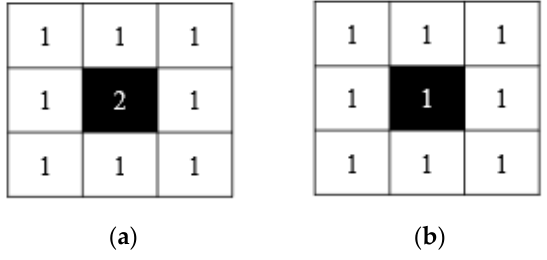
Figure 6. Gaussian Blur. ( a ) Raw image ( b ) after blurring. The first image is the raw image with a pixel value of 2 for the central pixel, and the second image is the image after blurring the central pixel, with the pixel value being the average of the sum of the surrounding pixel values. The Gaussian blurring process uses a two-dimensional normal distribution, with the central pixel as the origin and the other points assigned weights according to their positions on the normal curve, to obtain a weighted average, and each point is multiplied by its own weight to obtain a weighted average of the Gaussian blurred value of the central point.